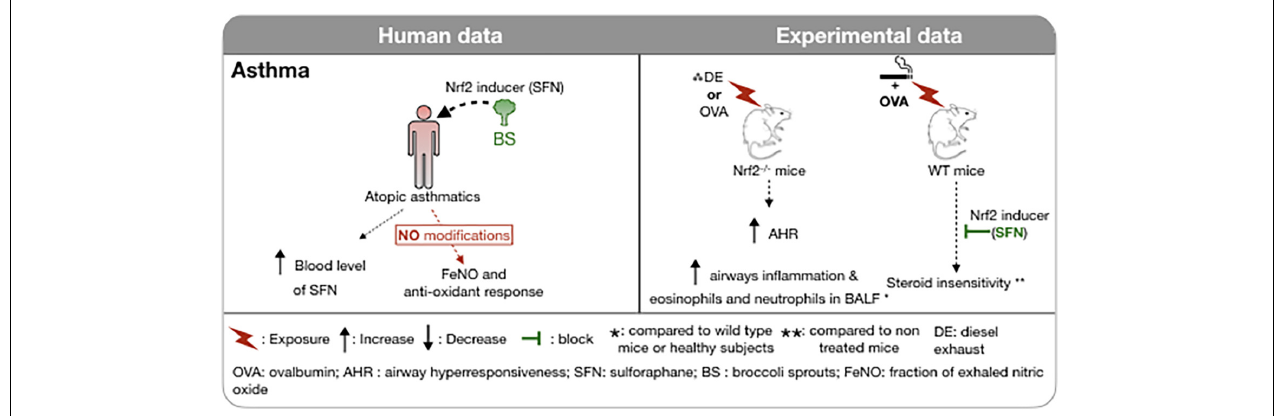
FIGURE 4 | Involvement of Nrf2 in asthma in humans and in experimental models. The administration of foods rich in sulforaphane (broccoli sprouts) in atopic asthmatic subjects increased plasma SFN concentration without any modification of the FeNO or of the antioxidant response. Induction of asthma in Nrf2-deficient mice is associated with increased airway hyperresponsiveness and inflammatory cell recruitment in BAL. Administration of an Nrf2 inducer restores the corticosteroid sensitivity of ovalbumin-induced asthma concomitantly exposed to cigarette smoke. ↑ , Increase; ↓ , Decrease; , block; , exposure; *, compared to wild type mice or healthy subjects; **, compared to non treated mice; DE, diesel exhaust; OVA, ovalbumin; AHR, airway hyperresponsiveness; SFN, sulforaphane; BS, broccoli sprouts; FeNO, fraction of exhaled nitric oxide; WT, wild